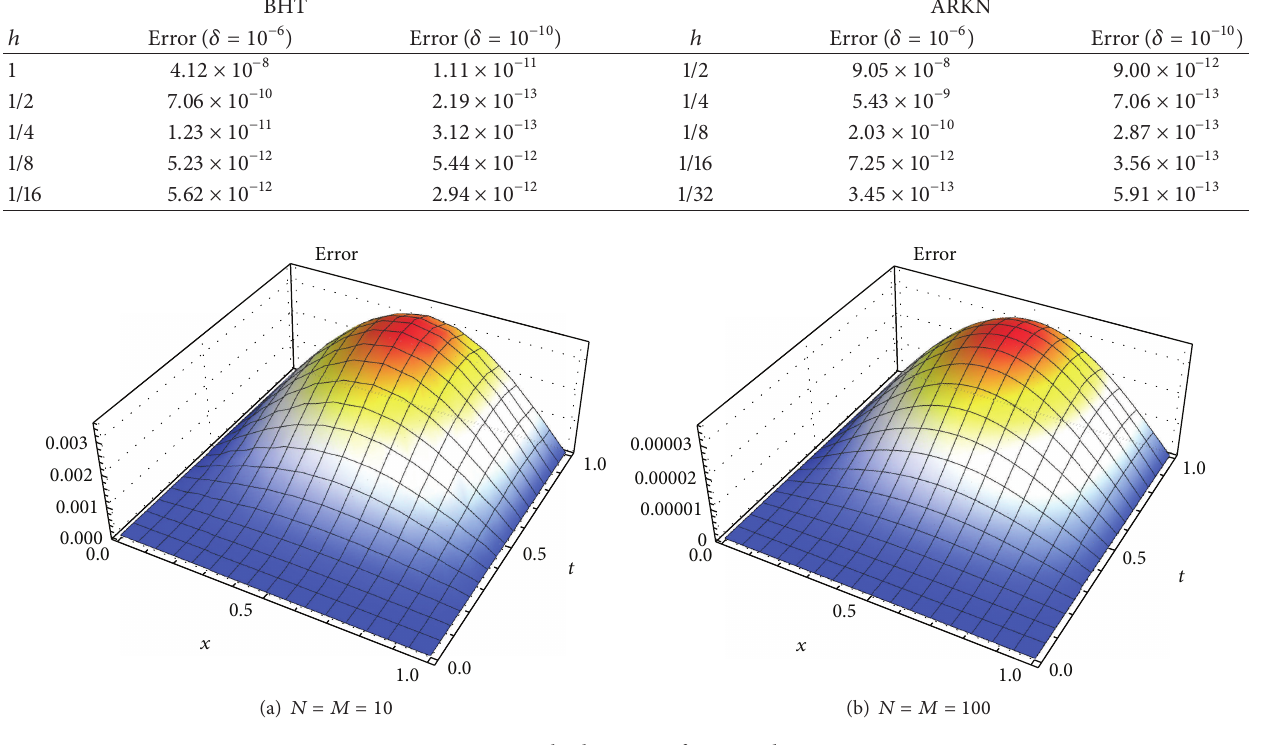
Figure 5: Absolute errors for Example 7.